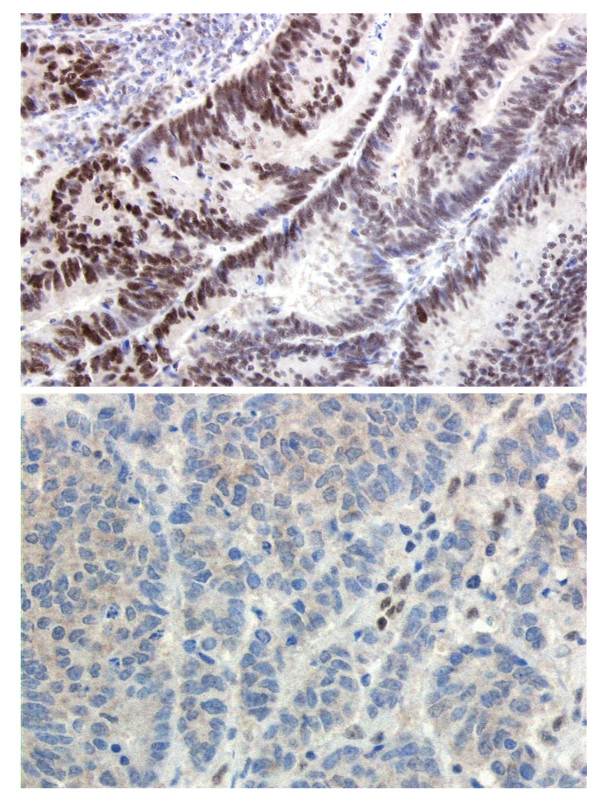
hMLH1 immunohistochemistry. Present (top panel) and absent (bottom panel) immunohistochemical staining for hMLH1.